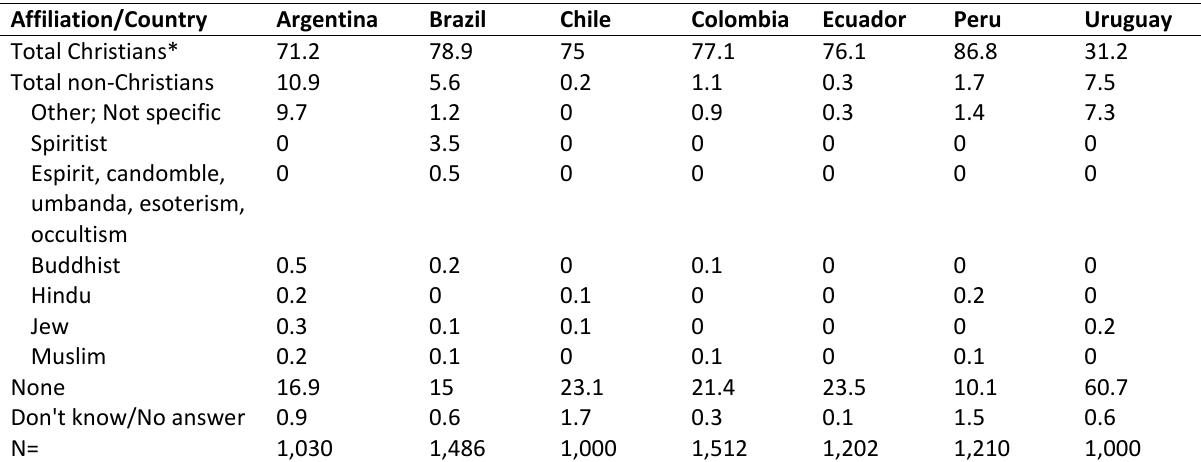
Table 2. Percentage of Christians and non-Christians.